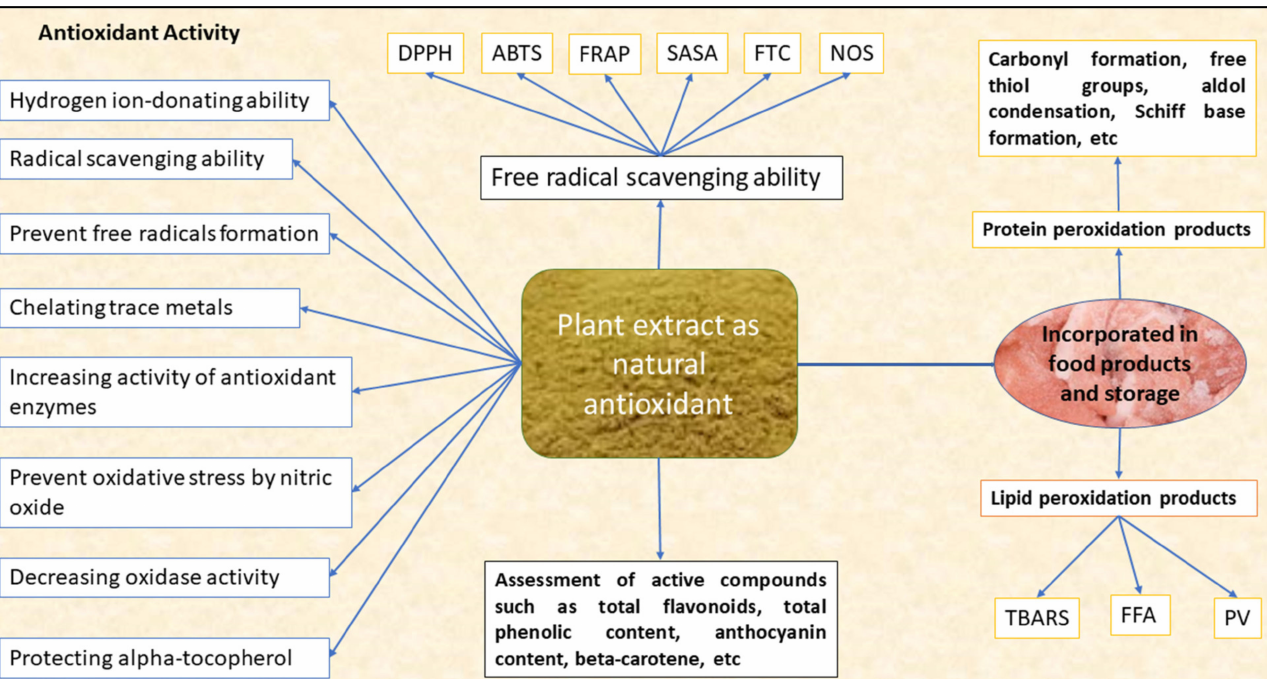
Figure 1. Overview of the antioxidant activity of the bioactive compounds extracted from a plant biomass source [7,8]. DPPH-1,1-diphenyl-2-picrylhydrazyl radical-scavenging activity, ABTS-2-2-azinobis-3ethylbenthiazoline-6-sulphonic